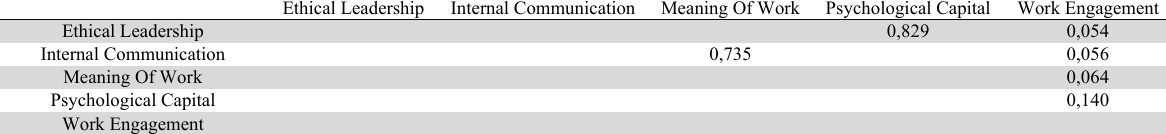
The results of f-Square (f 2 )